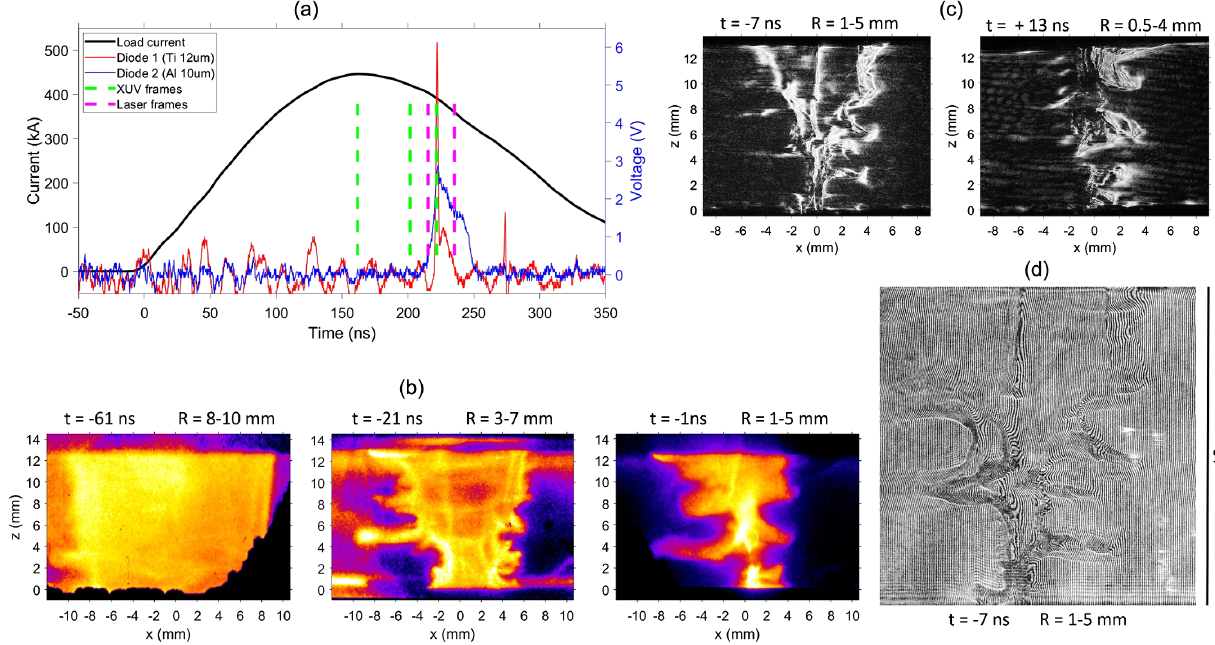
FIG. 8. Example of a gas puff Z pinch on CESZAR with a single, hollow Ar gas shell. (a) Current pulse, x-ray photodiode signal, timing of XUV gated camera, and laser pulses. (b) Sequence of time-gated XUV pinhole images. The color scheme and contrast of the images have been enhanced for clarity. A time stamp relative to the x-ray peak emission and an interval of values for the radius, between the leading edge of the bubbles and the trailing edge of the plasma, are reported above each image. (c) Laser schlieren images. (d) Laser Nomarski interferogram. In all the images (b) – (d), the gas injection is from the anode electrode at the top of the